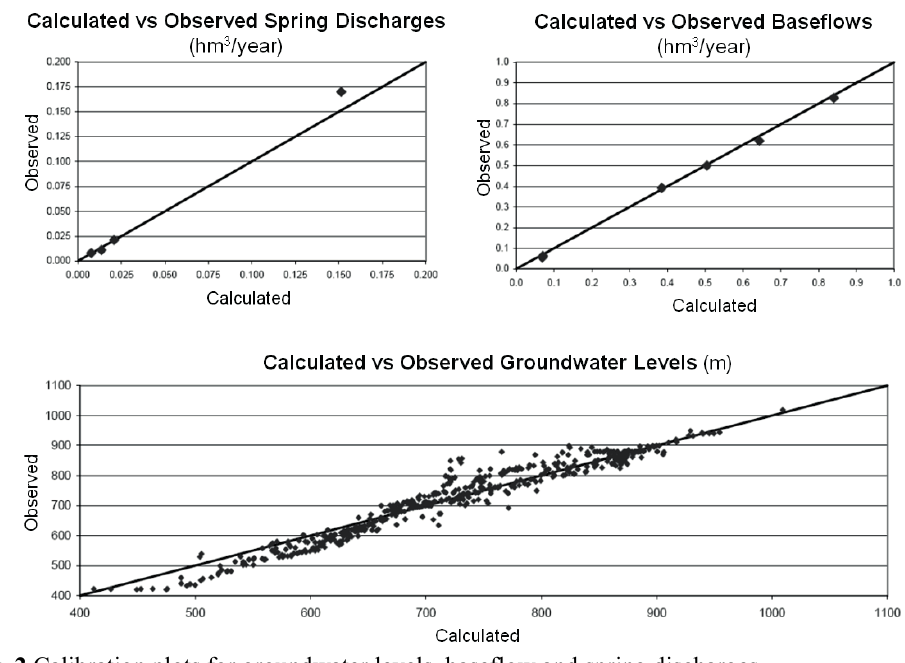
Fig. 2 Calibration plots for groundwater levels, baseflow and spring